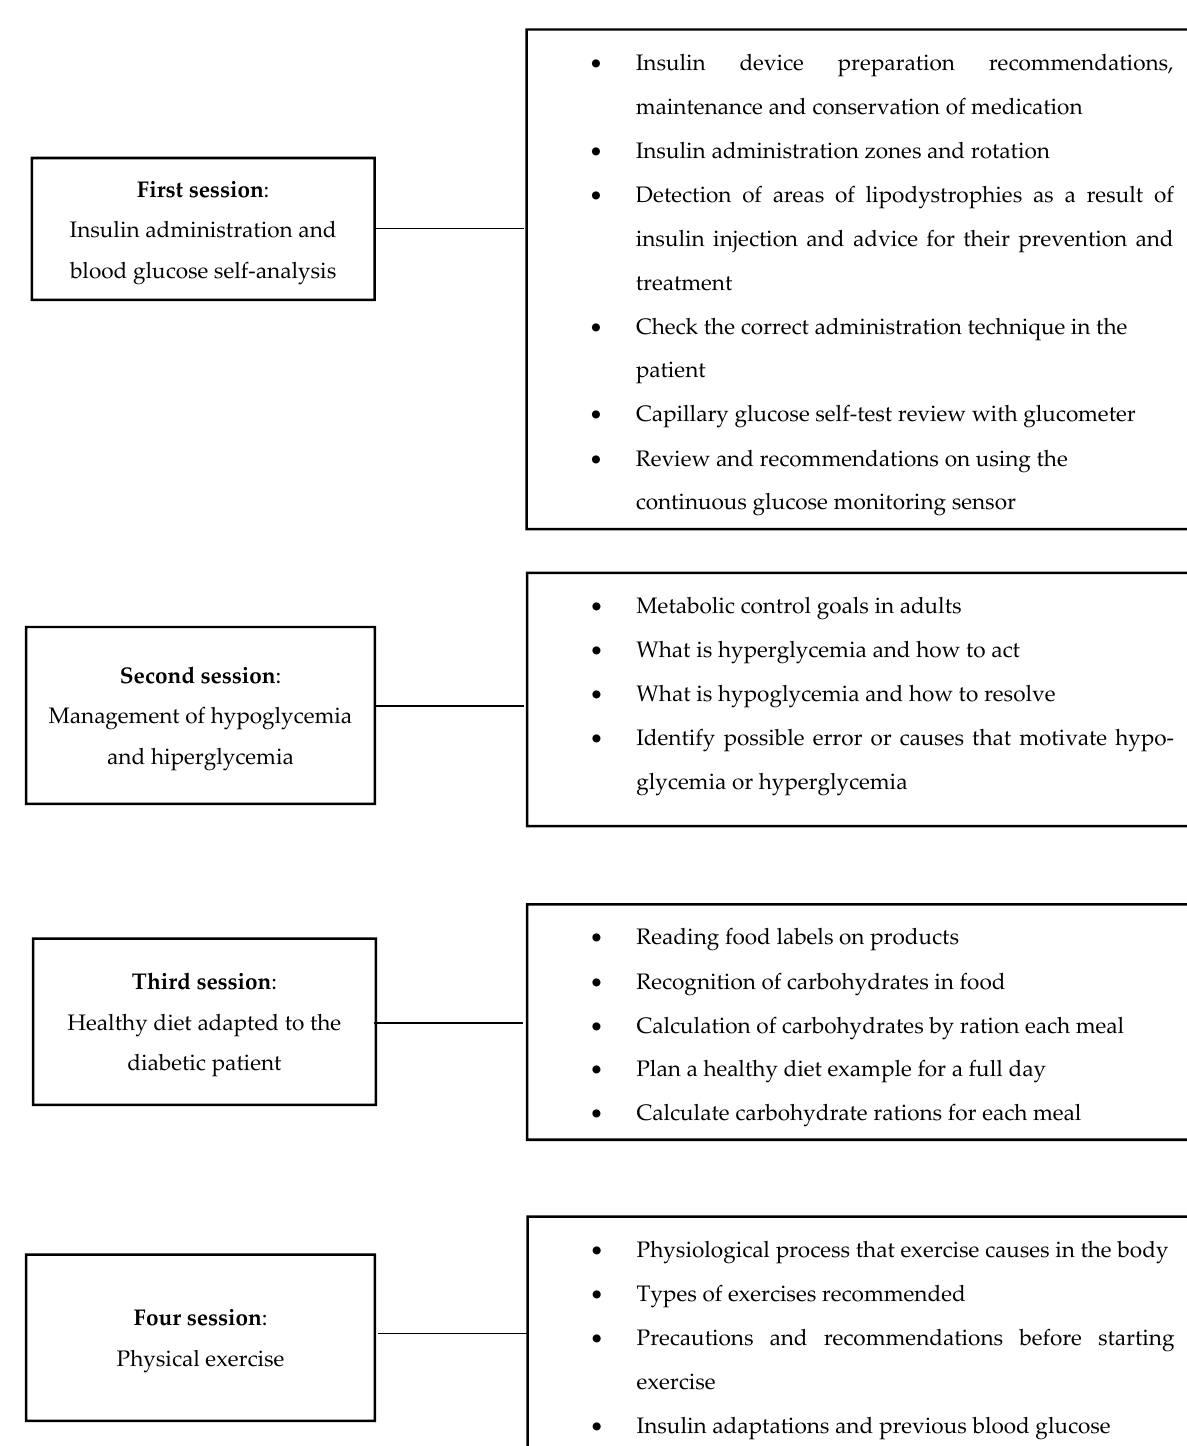
Figure 1. Structure of the diabetes education program.